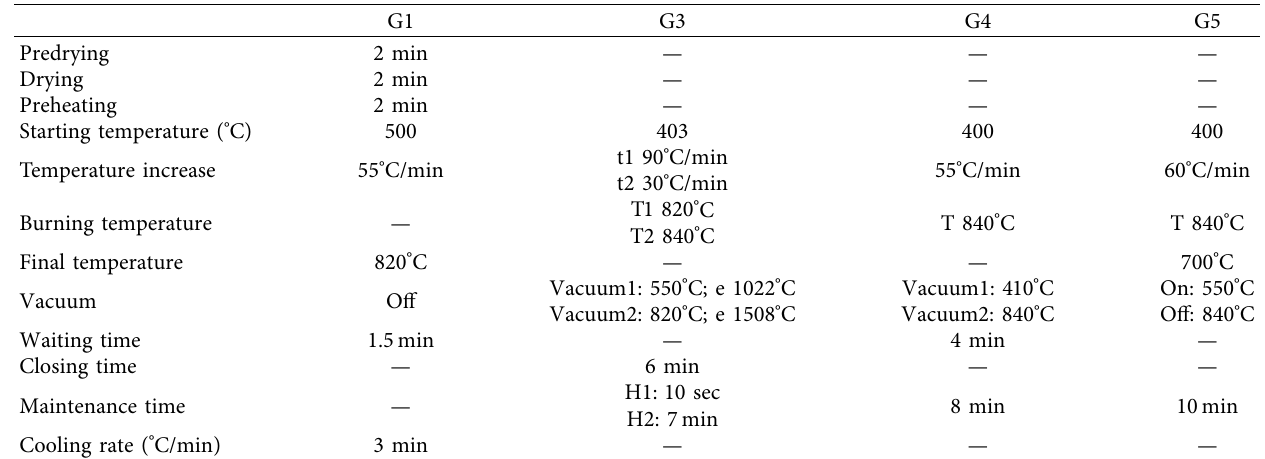
Table 2: Parameters used in the crystallization of the